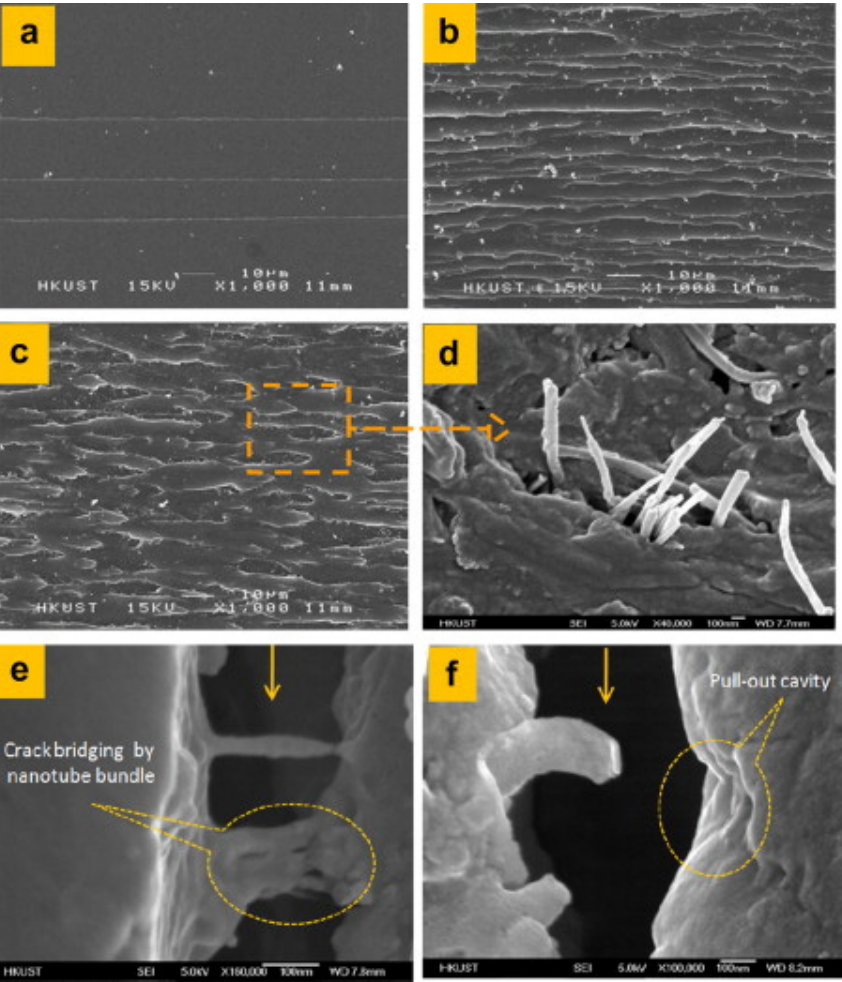
Figure 12. Quasi-static fracture surface morphologies of neat epoxy ( a ), 0.3 wt% of randomly distributed MWCNT-nanocomposites ( b ), 0.3 wt% of aligned MWCNT-nanocomposites ( c and d ), crack